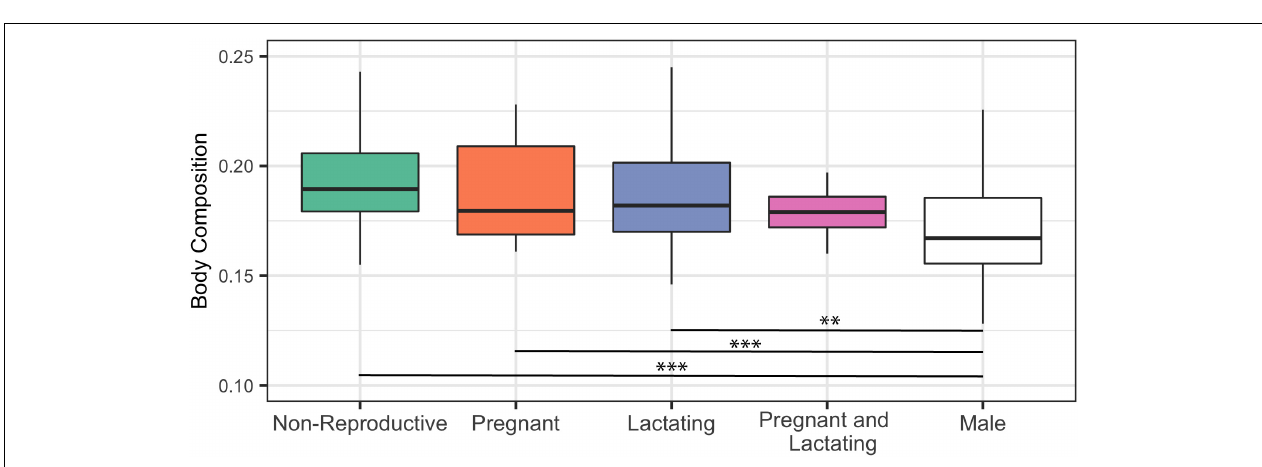
FIGURE 5 | Fitted generalized additive model with 95% confidence interval for the relationship between age and body composition for female and male ( n = 260 and n = 274, respectively) common bottlenose dolphins ( Tursiops truncatus ) in Sarasota Bay. Number of knots was restricted to one.